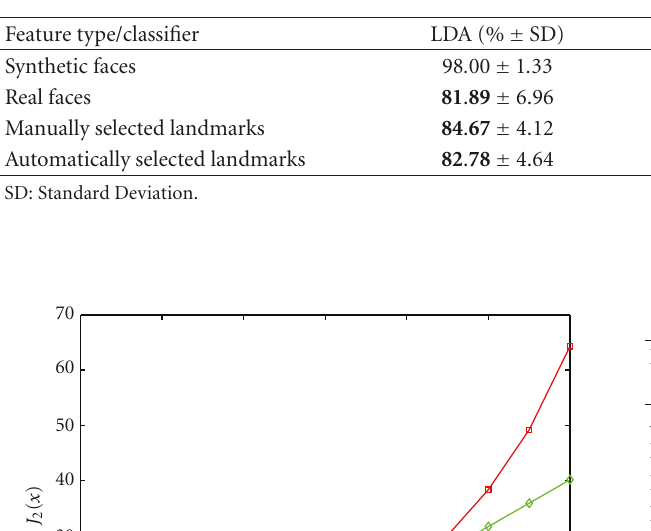
Table 1: Recognition rate.